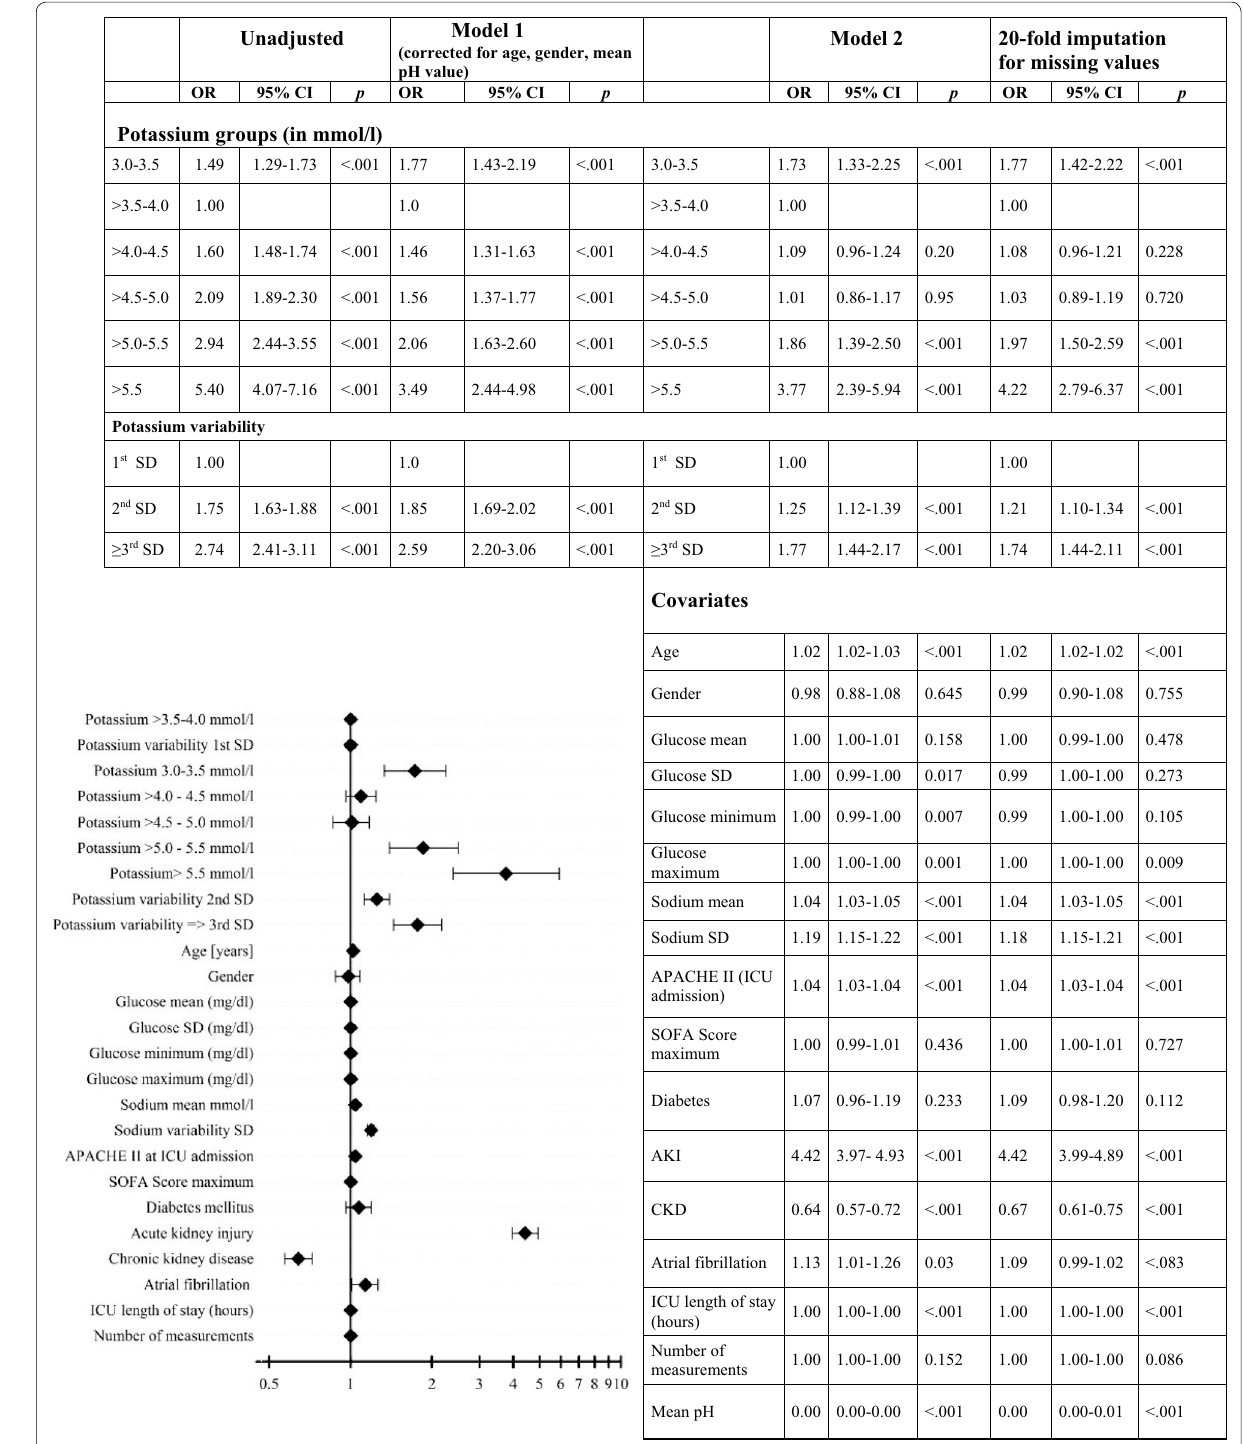
Fig. 3 Adjusted odds ratios for in‑hospital mortality. Reference for potassium categories is > 3.5–4.0 mmol/l, for potassium variability 1st SD. Unadjusted: n 53,248 patients. Adjusted model 1: n 30,558 patients, 22,690 missing values adjusted for gender, age and pH value. Adjusted = = model 2: n 25,636 patients, 27,612 missing values, adjusted for gender, age, glucose mean, glucose SD, glucose maximum, glucose minimum, = sodium mean, sodium SD, APACHE II score, SOFA score maximum, diabetes, acute kidney injury (AKI), chronic kidney disease (CKD), atrial fibrillation, number of measurements, ICU length of stay (in hours) and mean pH value; corrected for missing values by 20‑fold imputations. Blood glucose concentrations in mg/dl and sodium concentration in mmol/l. Forest plot of original data from model